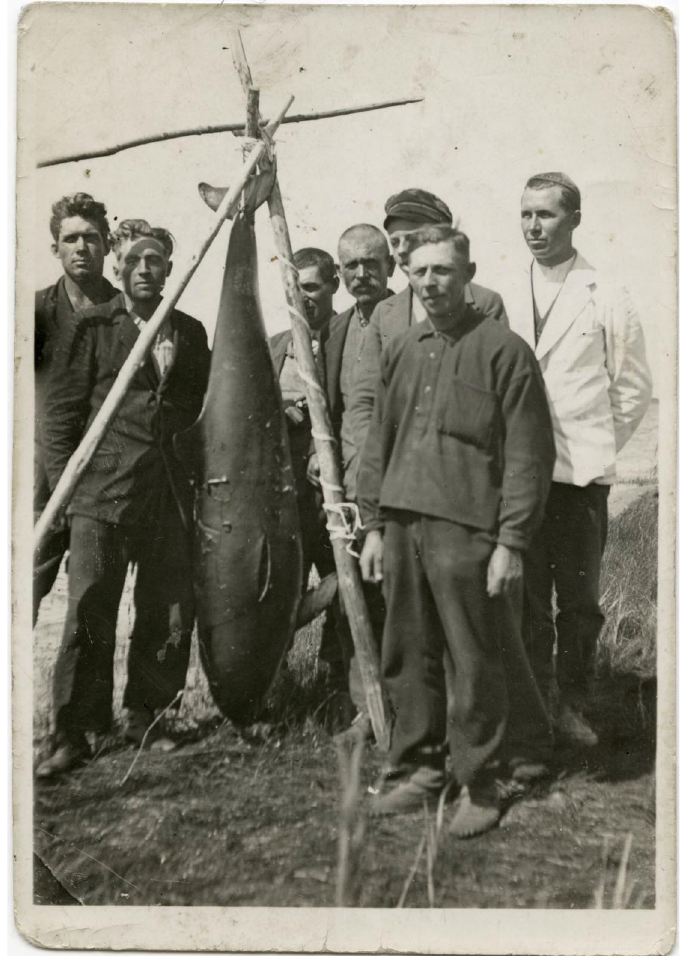
Figure 1. Fishermen with a strange fish in Virtsu, West Estonia, in 1939. Photo from the Virtsu Hobby Museum—VHM-F0441 [16].